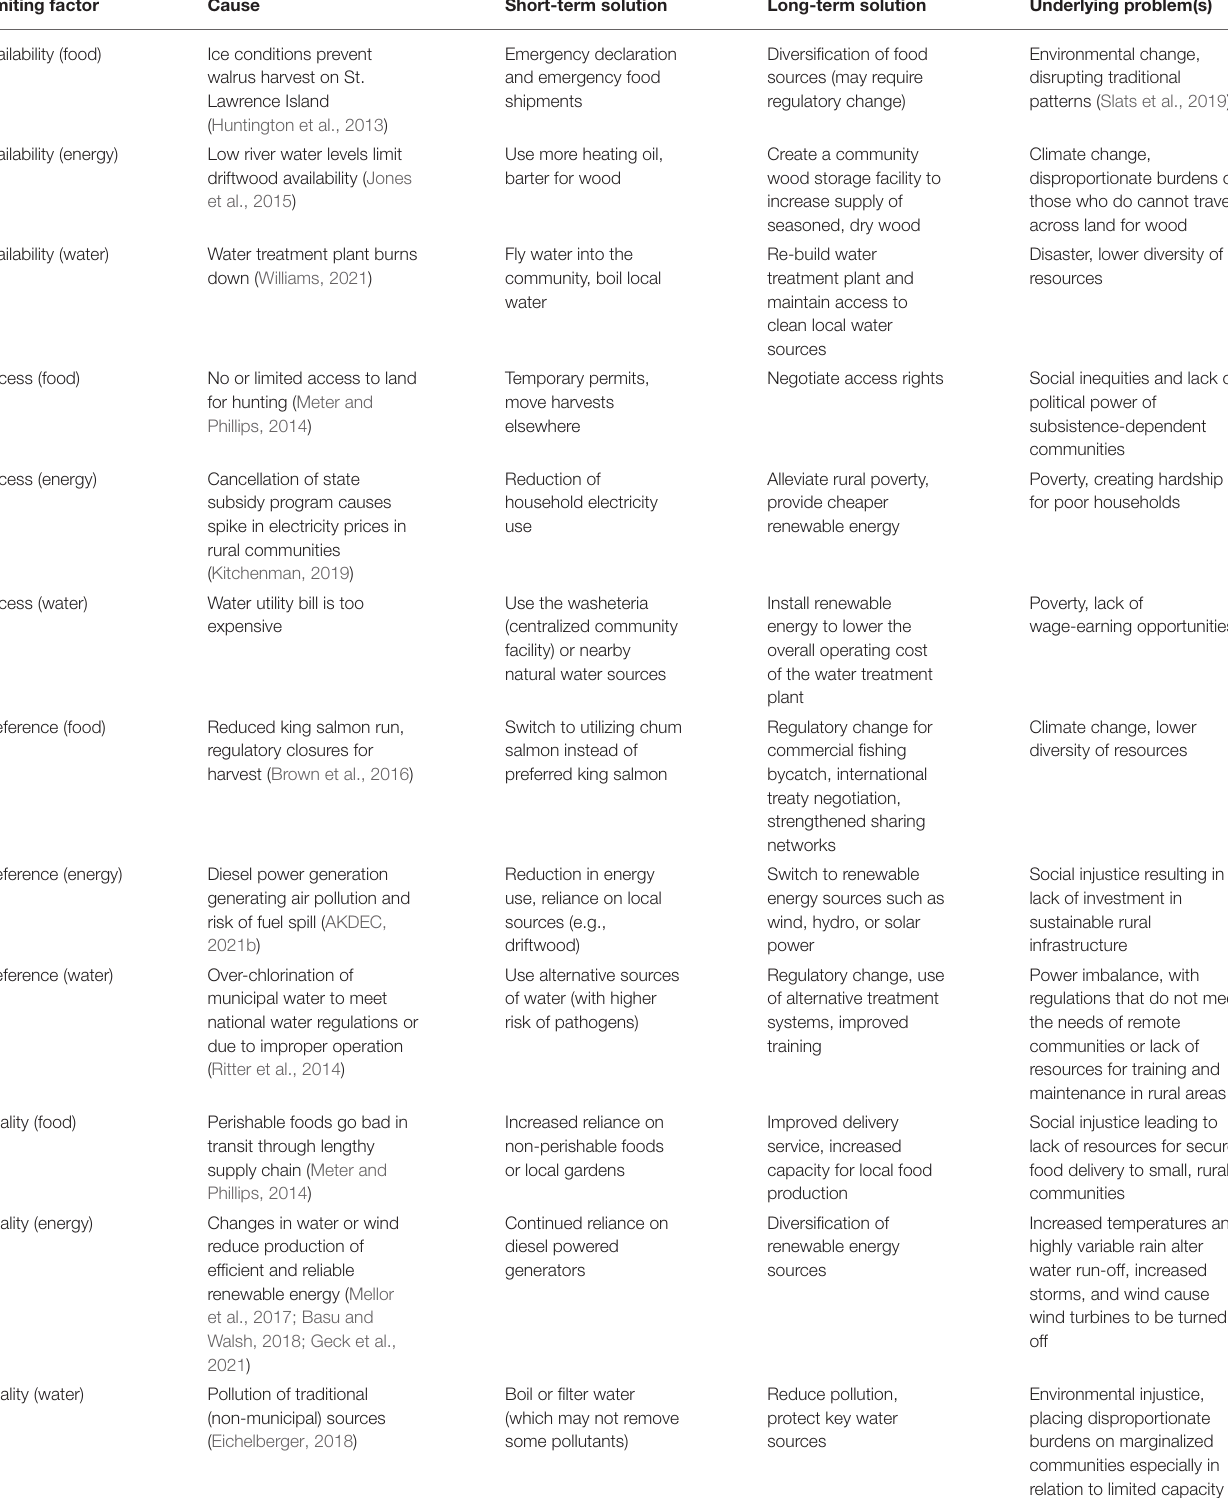
TABLE 2 | Examples from rural Alaska of limiting factors, causes, and solutions based on literature and our research. Limiting